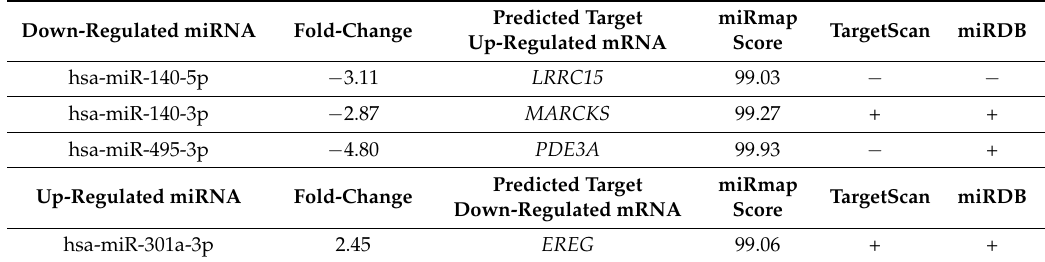
Table 5. Potential miRNA regulations of four identified genes in OA knee chondrocytes.